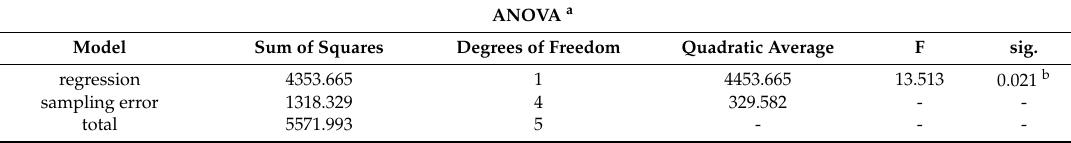
Table 6. Variance analysis for topographic settlement test and first modulus of PLT ( Φ 600mm) at crown. ANOVA a Model Sum of Squares